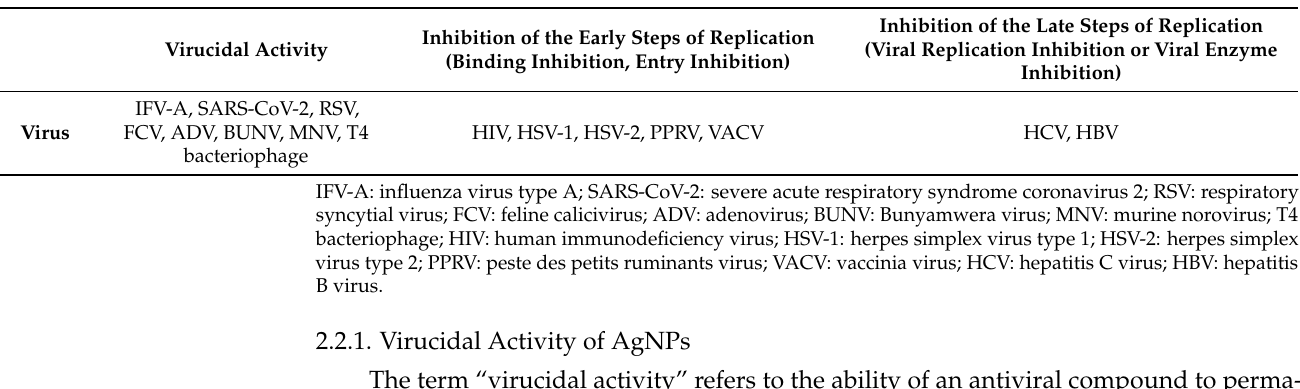
Table 2. Summary of the mechanisms of action of AgNPs against different